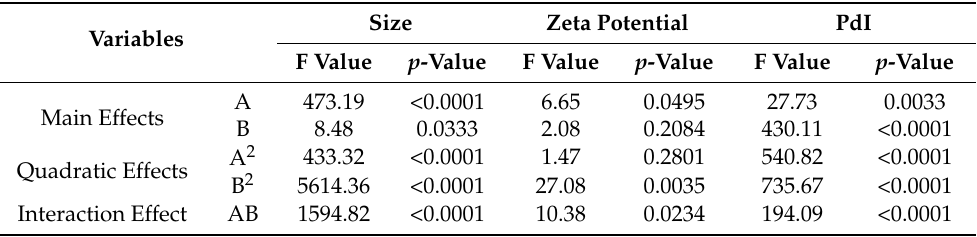
Table 2. ANOVA of regression coefficient of the fitted quadratic equation for